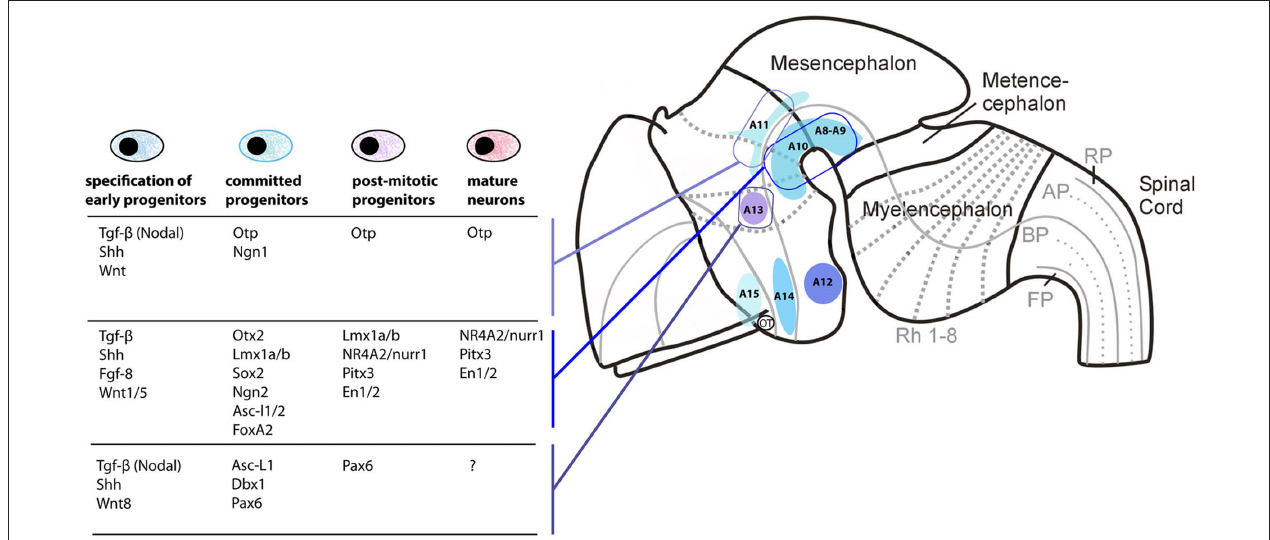
table. Note that DA cells in the three different areas depend on different signaling and transcription factors expression at each step of the cell differentiation, although little is still known in the case of A11 and A13. This observation supports the hypothesis that different DA neuronal systems have been recruited independently, by different transcriptional mechanisms, probably early in